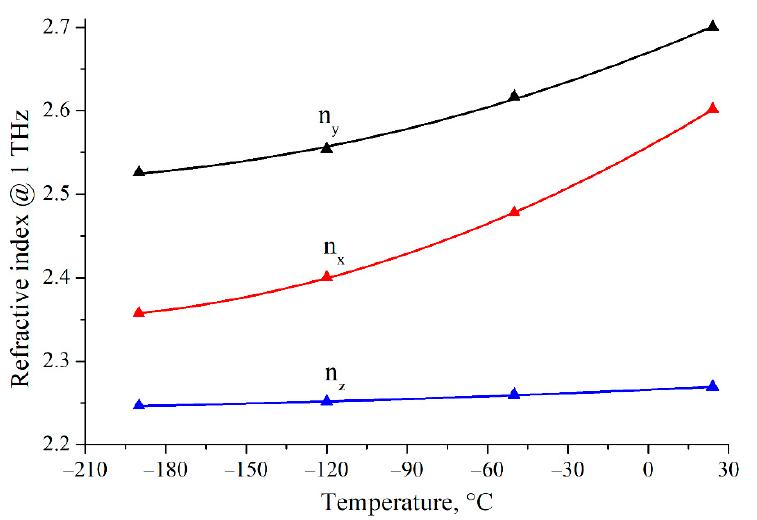
Figure 5. Temperature dependence of the refractive index at a frequency of 1 THz of LBO crystal